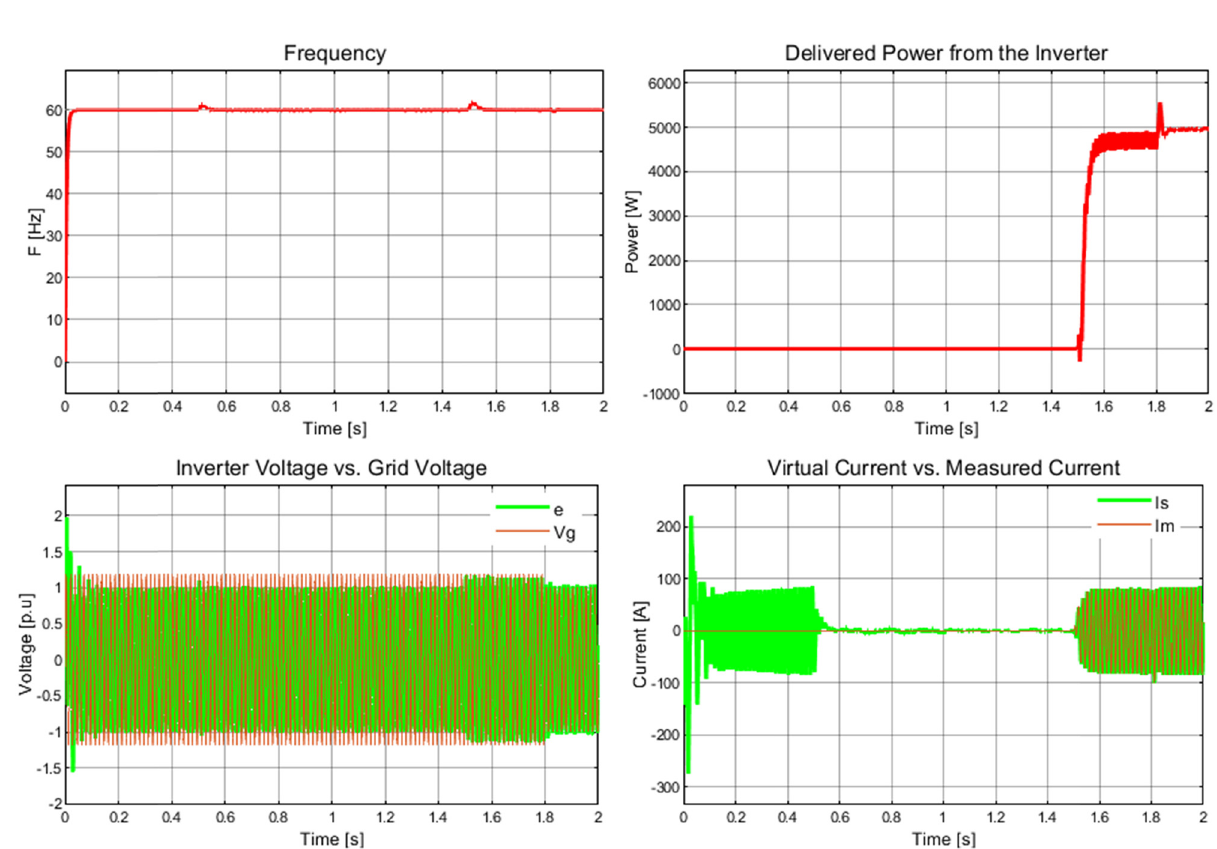
Figure 8: Results from Scenario 2 – connection to an unbalanced power